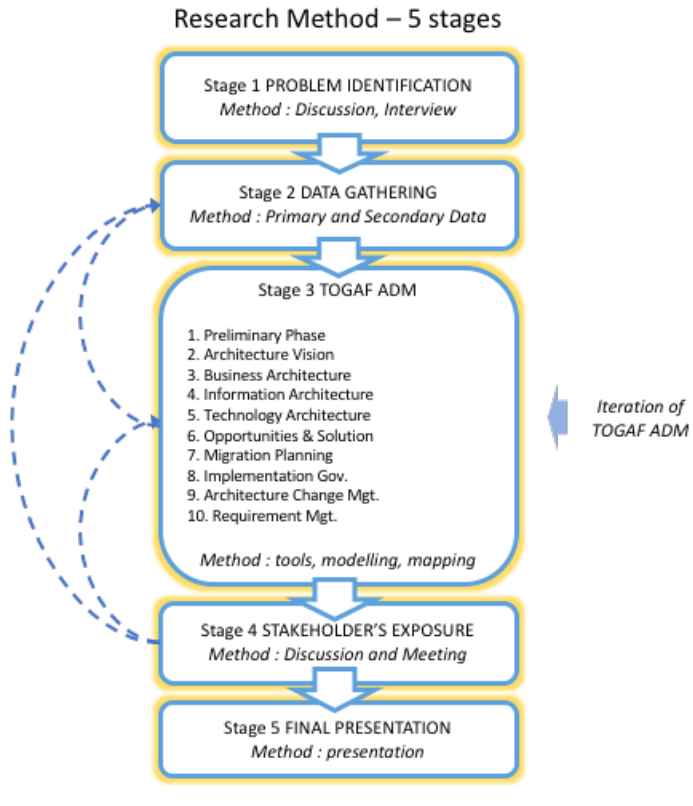
Figure 1. Research